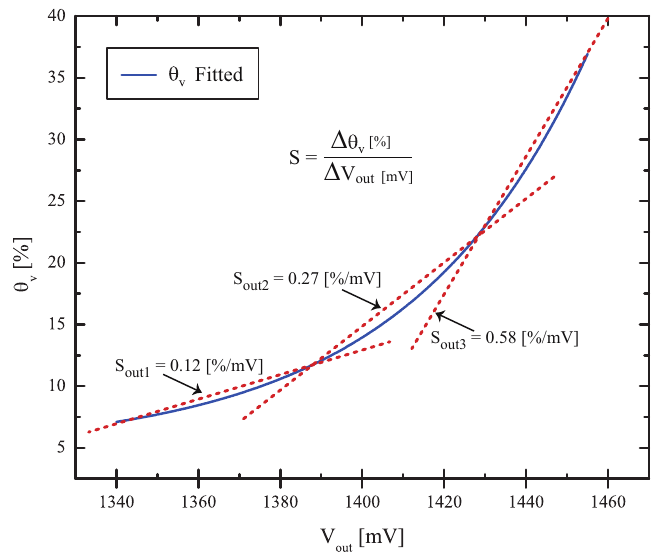
Figure 12. Linear approximation of the sensitivity S out = ∆ θ v / ∆ V out in three different